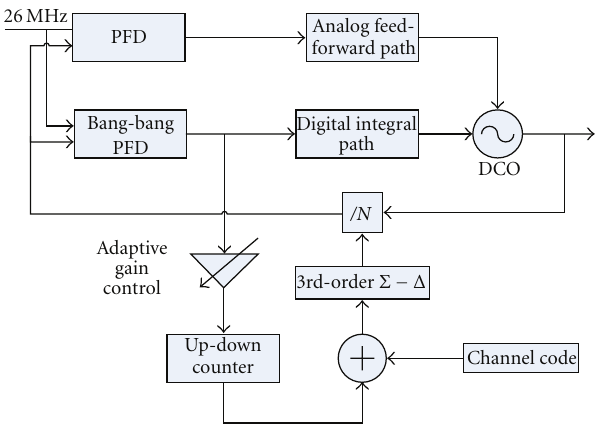
Figure 1: Block diagram of DCO gain calibration as used in